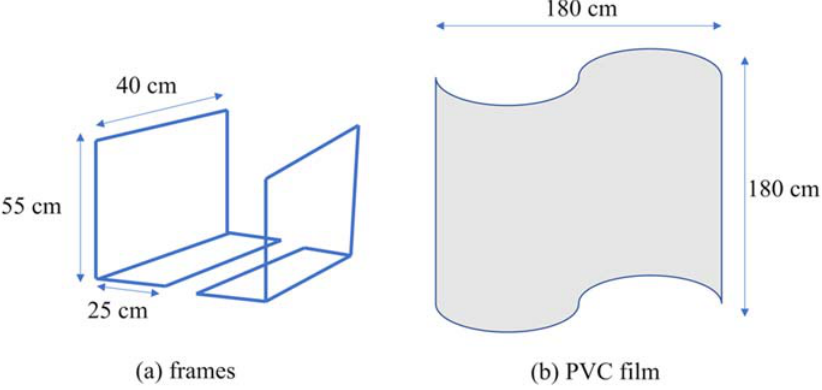
Figure 1. The schematic design of the protection